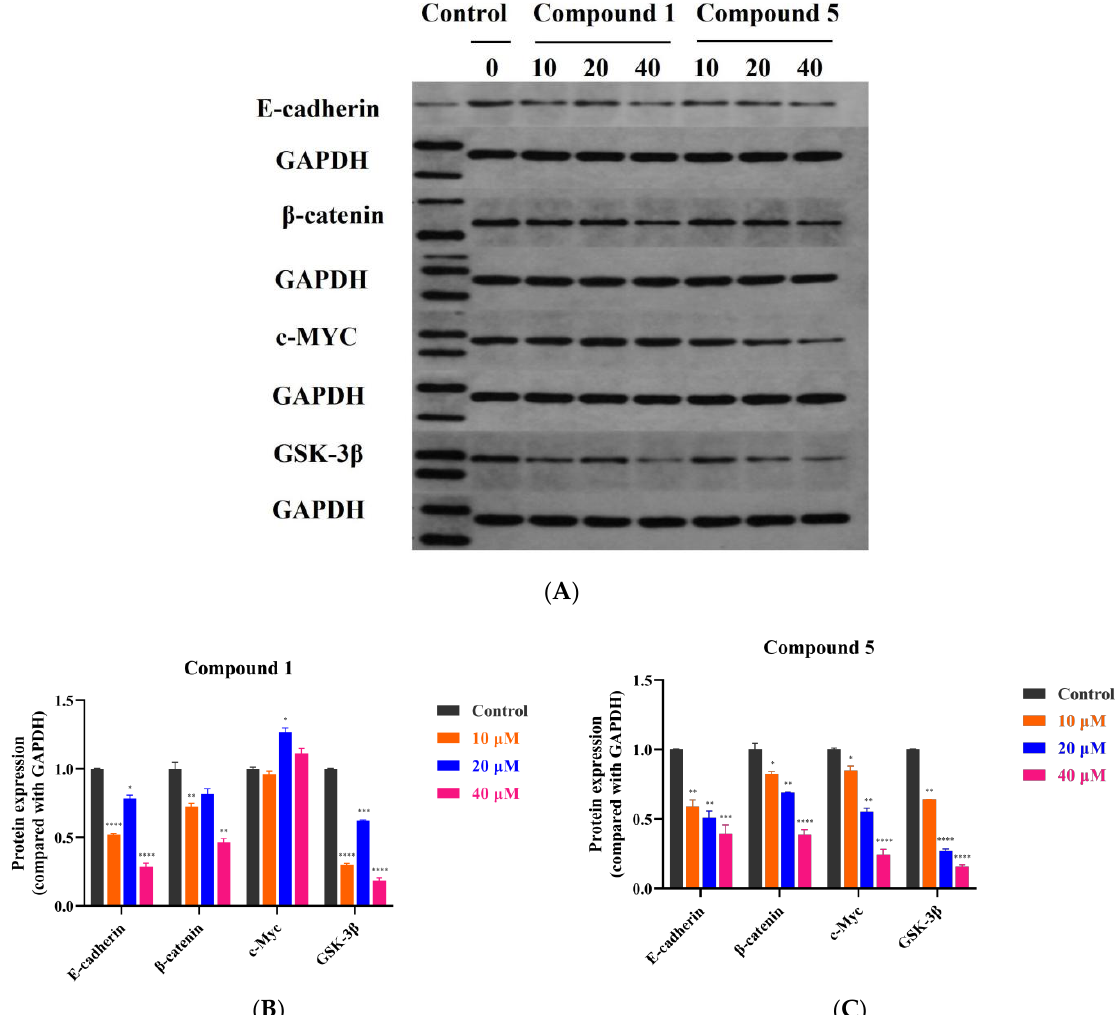
Figure 8. The effects of compounds 1 and 5 on the Wnt/β -catenin signaling pathway in RKO cells. ( A ) Expression of E-cadherin, β -catenin, c-Myc and GSK- 3β proteins were determined by Western blotting after cells were treated with 10, 20 and 40 μM for 48 h, respectively. ( B , C ) Statistics of Western blotting results. * p < 0.05, ** p < 0.01, *** p < 0.001, **** p < 0.0001, compared with control groups.